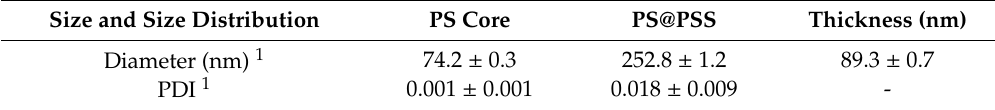
Table 1. Size of hairy nanoparticles by Dynamic Light Scattering